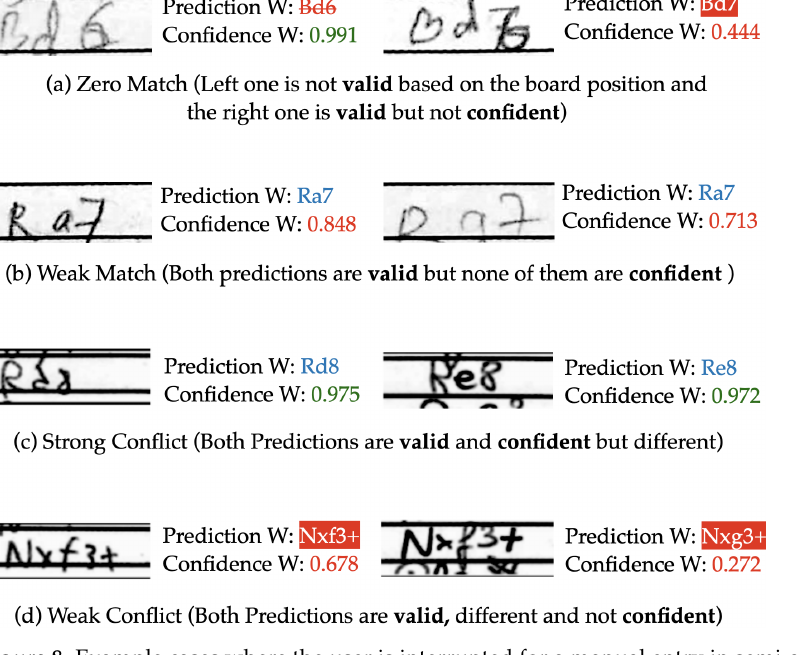
Figure 8. Example cases where the user is interrupted for a manual entry in semi-autonomous post processing system: ( a ) zero match; ( b ) weak match; ( c ) strong conflict; ( d ) weak